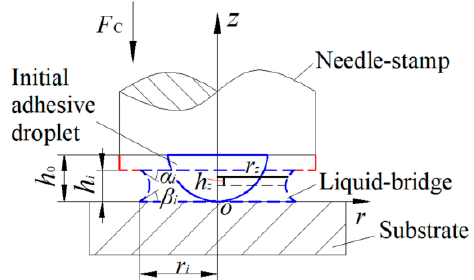
Figure 2. Schematic diagram of the initial droplet being squeezed.